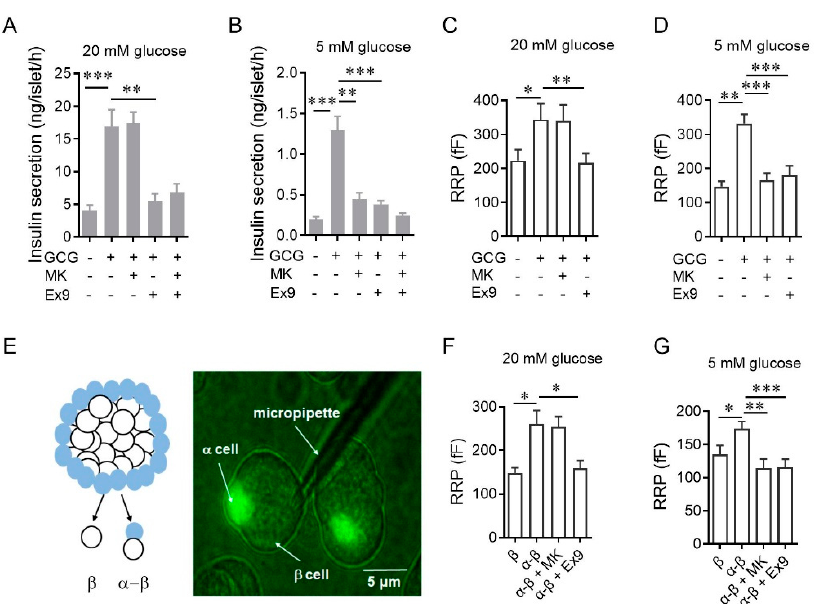
Figure 1. Glucagon potentiates insulin secretion via β -cell glucagon receptors (GCGR) at physiologi- cal doses of glucose. ( A , B ) Effects of MK0893 or Exendin 9-39 on 100 nM glucagon-induced insulin secretion of isolated mouse islets in 20 mM ( A ) and 5 mM glucose ( B ) ( n = 5–7 per group). Glucagon is abbreviated as GCG, MK0893 is abbreviated as MK, and Exendin 9-39 is abbreviated as Ex9 in the figures. ( C , D ) Effects of MK0893 or Exendin 9-39 on 100 nM glucagon-increased RRP size of single β -cells isolated from C57BL/6J mice in 20 mM glucose ( C ) or 5 mM glucose ( D ) ( n = 16–25 per condition). ( E ) Perforated patch on a α - β cell cluster. Left panel: schematic depicting the dissociation of GYY mouse islets into a α - β cell cluster or a single β -cell. Right panel: representative image of a perforated patch performing on a α - β cell cluster. ( F , G ) Effects of MK0893 and Exendin 9-39 on the RRP size of β -cells in α - β cell clusters isolated from GYY mice in 20 mM glucose ( F ) or 5 mM glucose ( G ) ( n = 16–23 per condition). Statistical significance was evaluated using Student’s t -test for single Gaussian-distributed datasets or the Mann–Whitney rank-sum test for non-single Gaussian-distributed datasets. * p < 0.05, ** p < 0.01, *** p < 0.001.